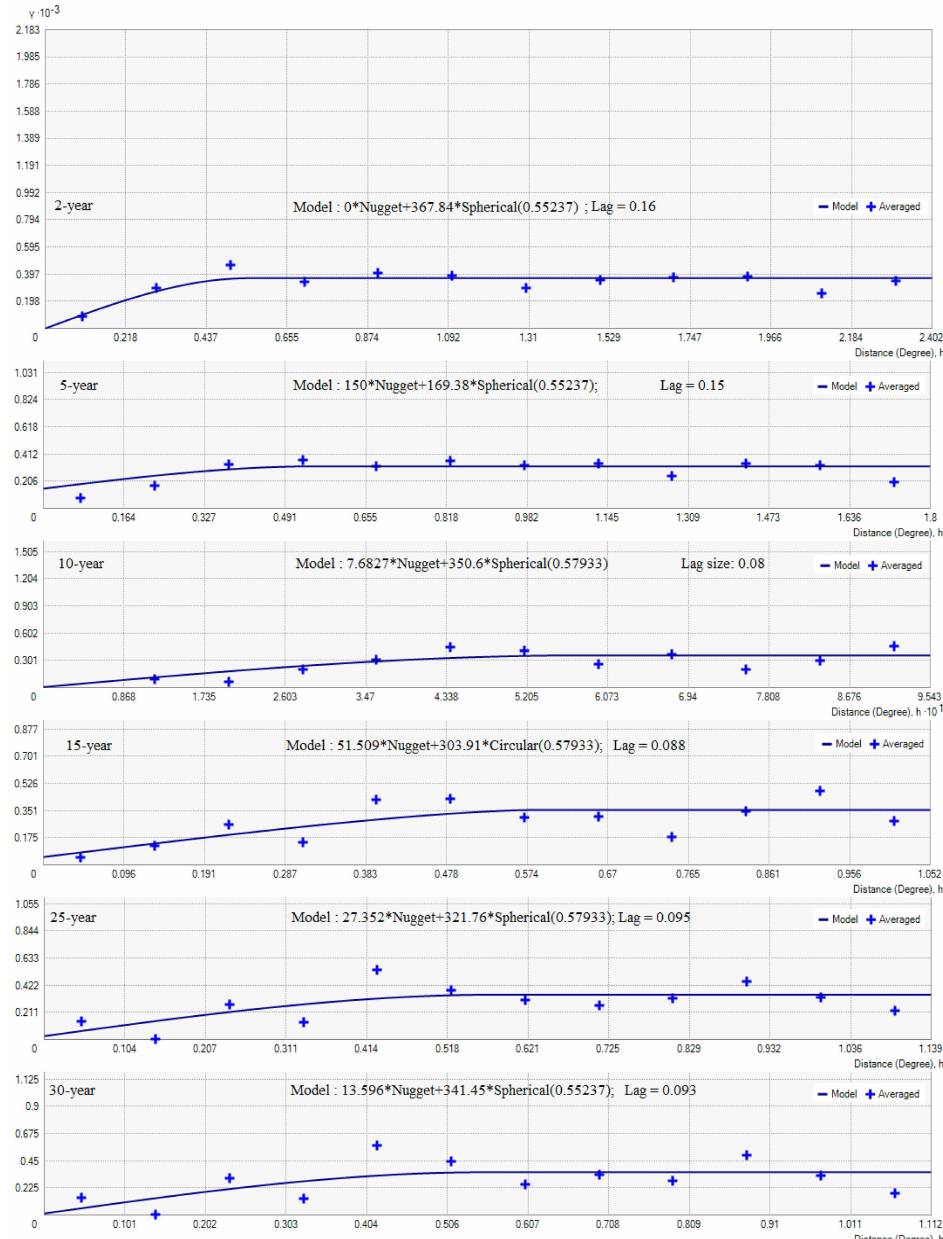
Figure A11. Modelled variograms corresponding to the percentage changes in heavy rainfall of different return